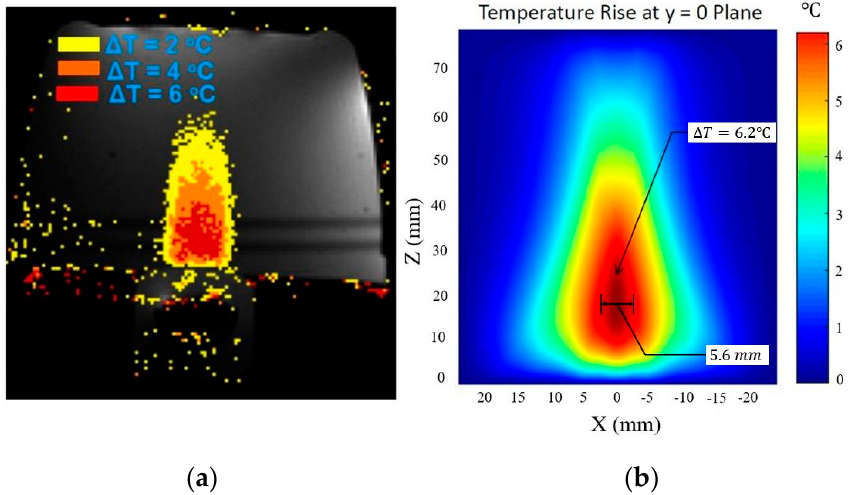
Figure 5. ( a ) Experimental observation of temperature rise in tissue-mimicking phantoms using Exablate 2100 [37]. ( b ) Temperature rise field by using the modified angular spectrum and bio-heat transfer model.